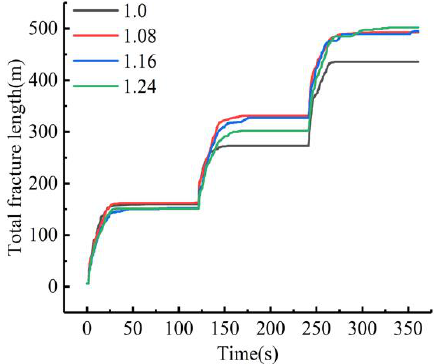
Figure 20. Variation curves of the total fracture length of segmental hydraulic fractures in CBM reservoirs under various values of the inhomogeneity coefficient of the in situ stress.